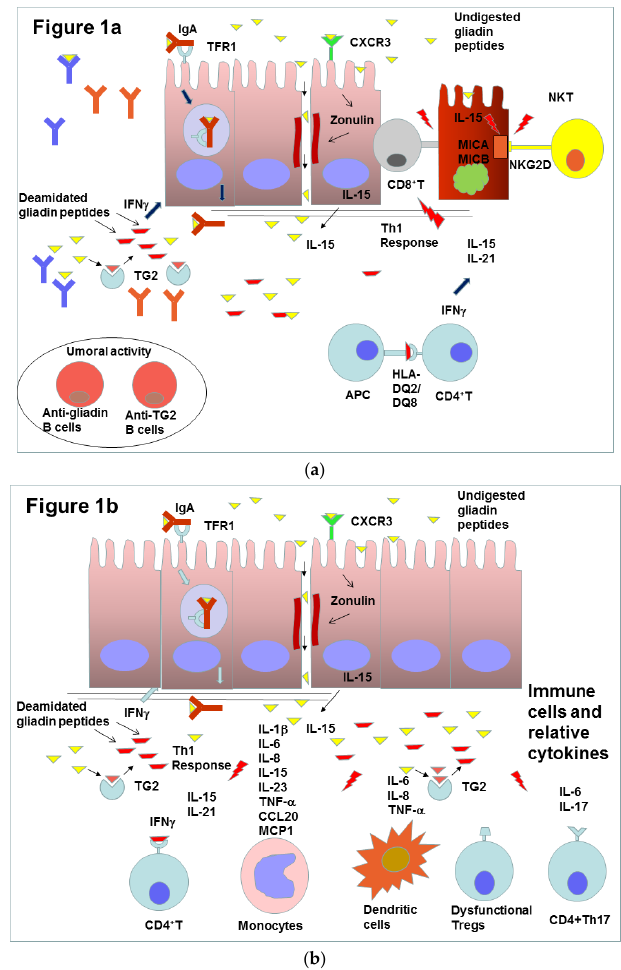
Figure 1. ( a ) Schematic representation of the effects of gliadin peptides on gut mucosa and immune cells. Gliadin peptides reach lamina propria, altering paracellular permeability by inducing zonulin expression or through transcytosis of gliadin peptides-IgA complexes mediated by transferrin receptor 1 (TFR1). Gliadin peptides are deaminated by the enzyme transglutaminase 2 (TG2). The deaminated peptides are presented bound to HLA-DQ2 / DQ8 by APC to CD4 + T cells and induce Th1 response, activating IELs such as CD8 + Tcells, and Th2 response, activating B cells that produce specific antibodies against gliadin peptides and TG2. IL-15 stresses the epithelial cells to produce the surface glycoproteins MICA and MICB, which are recognized by the receptors NKG2D and CD9 / NKG2A of NKT-lymphocyte (NKT). When NKT receptors bind these molecules, they cause apoptotic death of the enterocytes. Figure ( b ) shows di ff erent types of leukocytes and in particular monocytes, dendritic cells and CD4 + Th17 cells, which produce cytokines that contribute to enhance gut